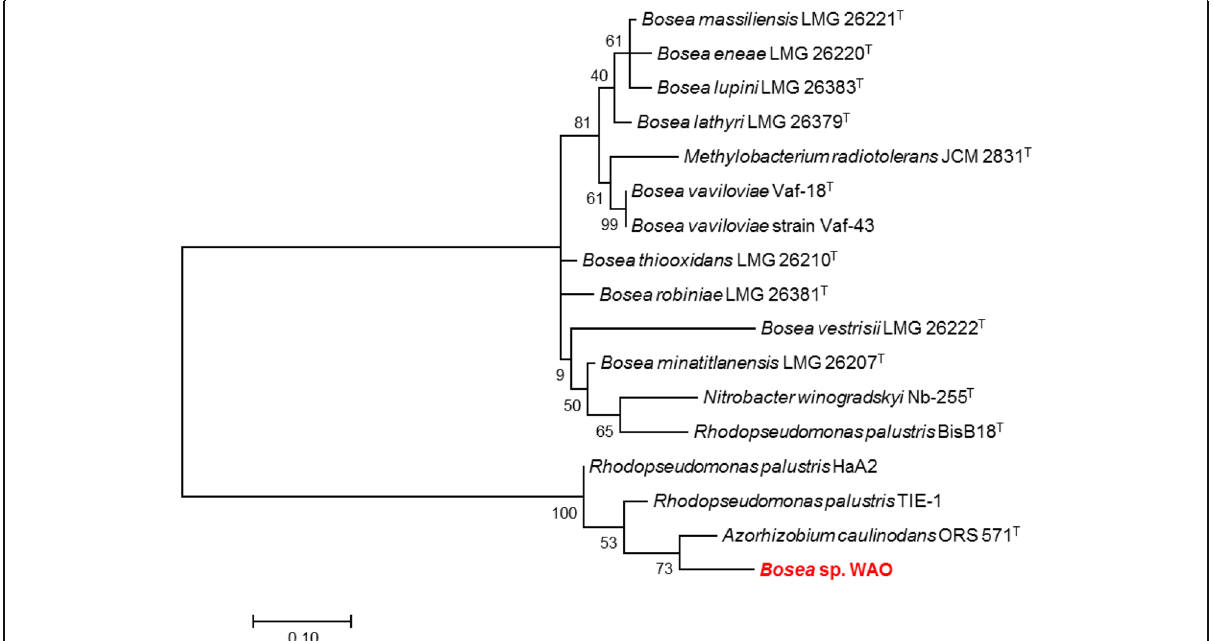
Fig. 6 Molecular Phylogenetic analysis by Maximum Likelihood method of recA gene. The evolutionary history was inferred by using the Maximum Likelihood method based on the Tamura-Nei model [19]. The tree with the highest log likelihood ( − 1263.1252) is shown. The percentage of trees in which the associated taxa clustered together is shown next to the branches. Initial tree(s) for the heuristic search were obtained automatically by applying Neighbor-Join and BioNJ algorithms to a matrix of pairwise distances estimated using the Maximum Composite Likelihood (MCL) approach, and then selecting the topology with superior log likelihood value. The tree is drawn to scale, with branch lengths measured in the number of substitutions per site. The analysis involved 17 nucleotide sequences. Codon positions included were 1st+2nd+3rd+Noncoding. All positions containing gaps and missing data were eliminated. There were a total of 190 positions in the final dataset. Evolutionary analyses were conducted in